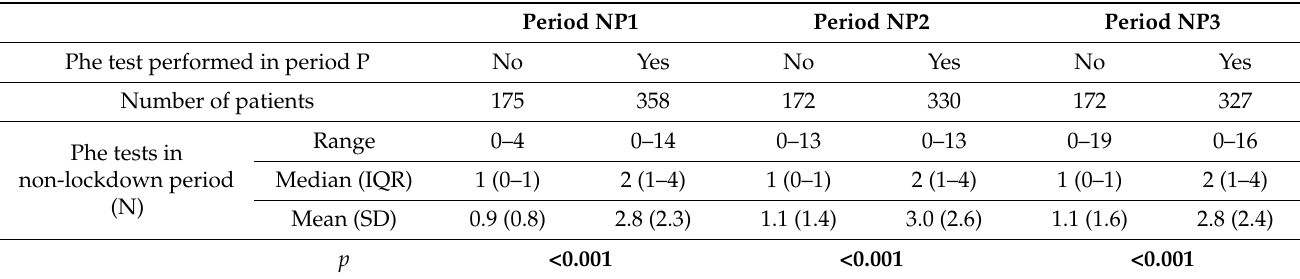
Table 5. The number of phenylalanine (Phe) tests in non-lockdown time intervals (periods NP1 to NP3) in patients who did/did not complete a Phe test in the lockdown period (period P).